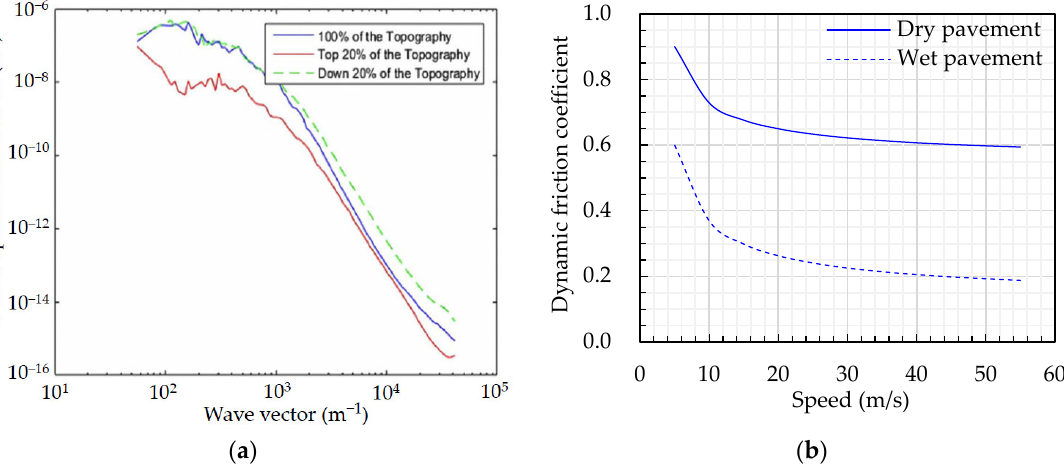
Figure 3. Acquisition of asphalt pavement texture information: ( a ) 2D ‐ PSD of the pavement texture; ( b ) dynamic friction coefficient curves.